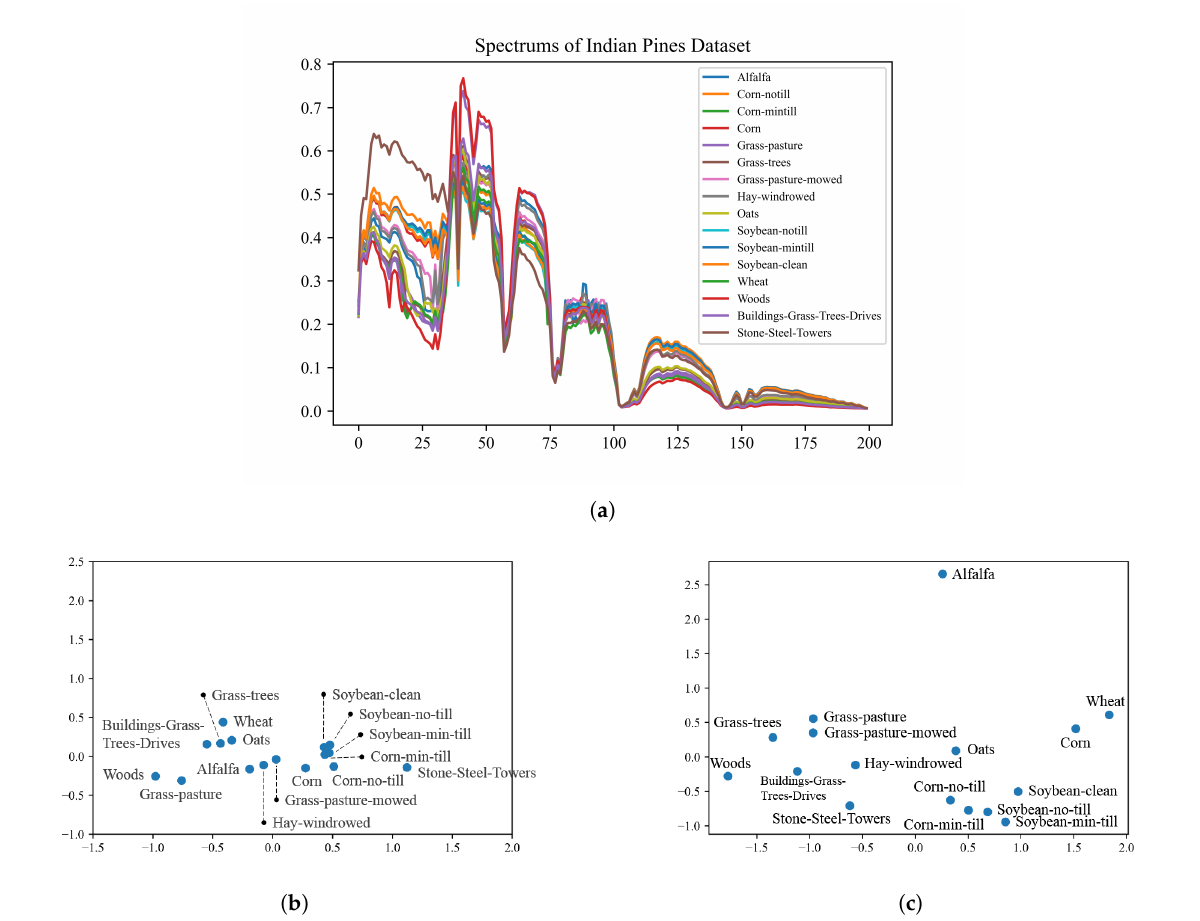
Figure 12. ( a ) Mean Spectrums curve of Indian Pines dataset, ( b ) PCA visualization of mean spectrums in 2-D, ( c ) PCA visualization of word2vec vectors in